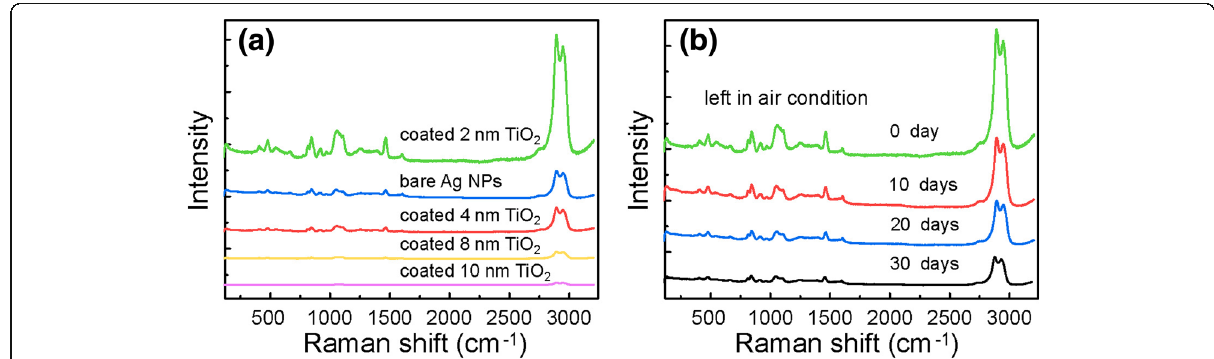
Fig. 6 Comparison of SERS glycerin spectra collected from a uncoated Ag NPs on glass sides and coated with TiO 2 of different thickness. b The substrate coated a 2-nm TiO 2 film in different duration left in air